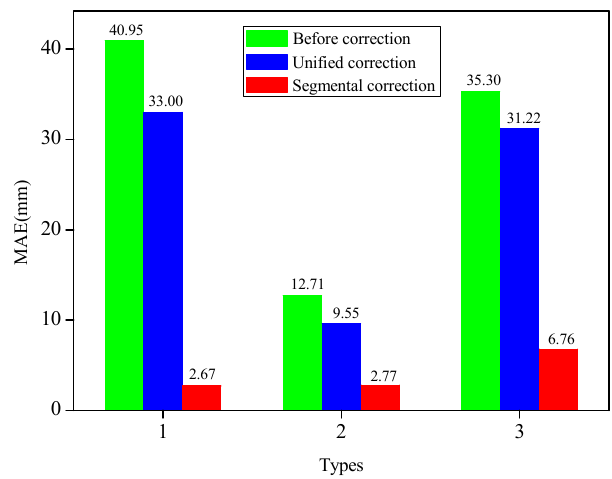
Figure 14. Comparison of MAEs based on different methods for Type 1, Type 2 and Type 3, respectively.